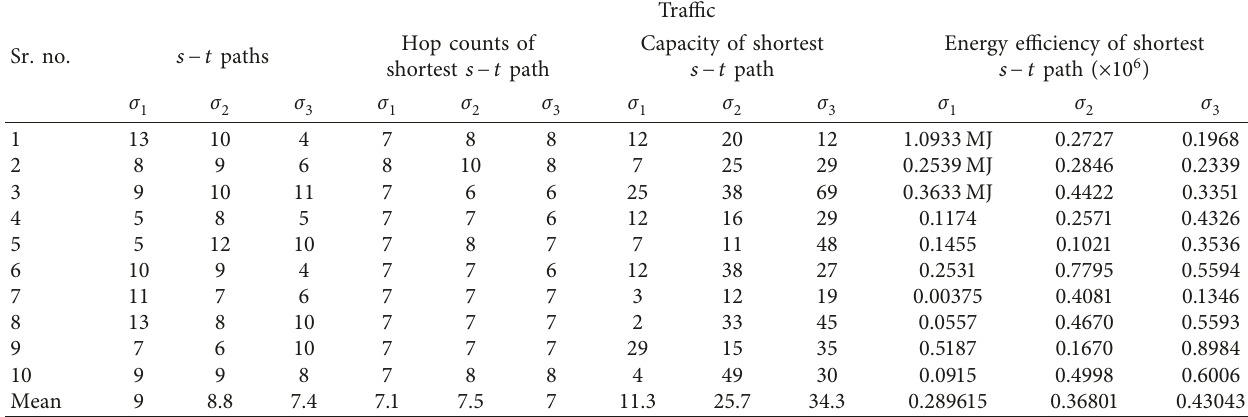
Table 1: Number of s − t paths, hop counts, capacity, and energy efficiency of the shortest s − t path. Sr. no.